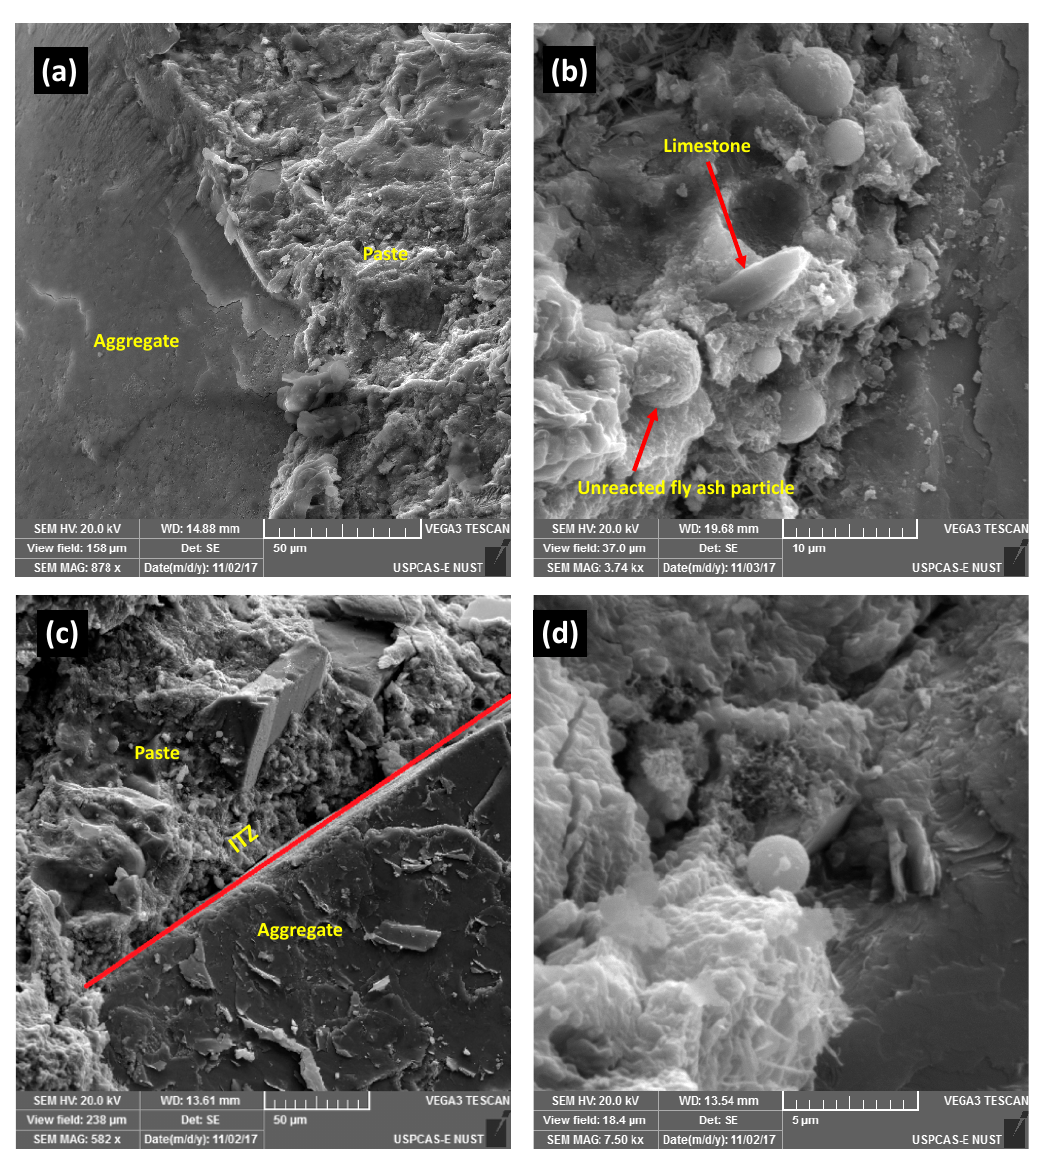
Figure 5. SEM of ( a ) SCNWC, ( b ) SCNWC + LSP + FA, ( c ) SCLWC, and ( d ) SCLWC + LSP + FA.